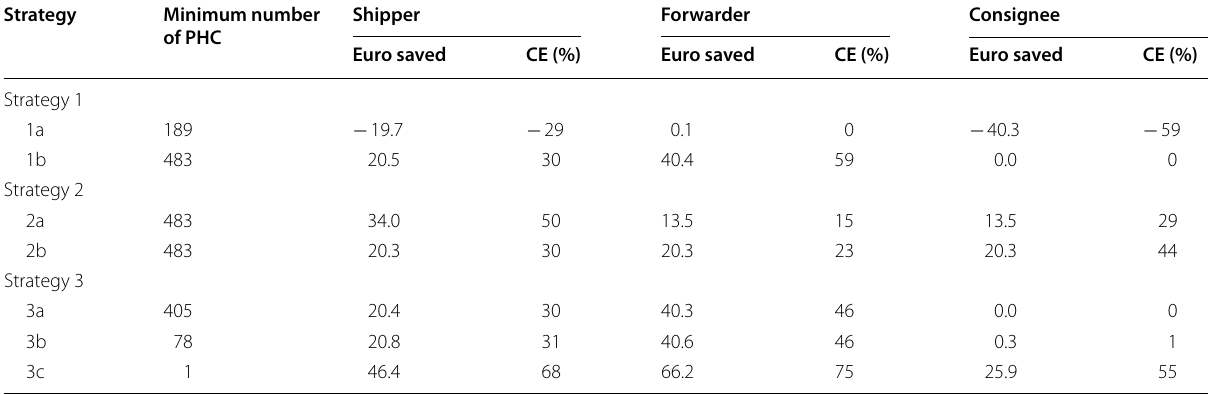
Table 4 Centralisation of analysis results. Source : own composition based on calculations Strategy Minimum number Shipper of PHC